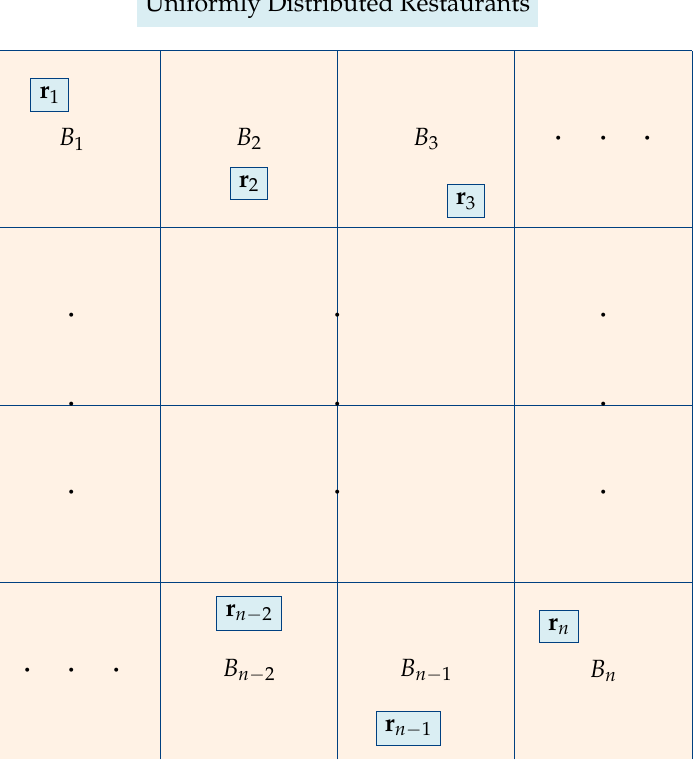
Figure 3. If the restaurants are uniformly distributed, then the expected number of restaurants in each region is